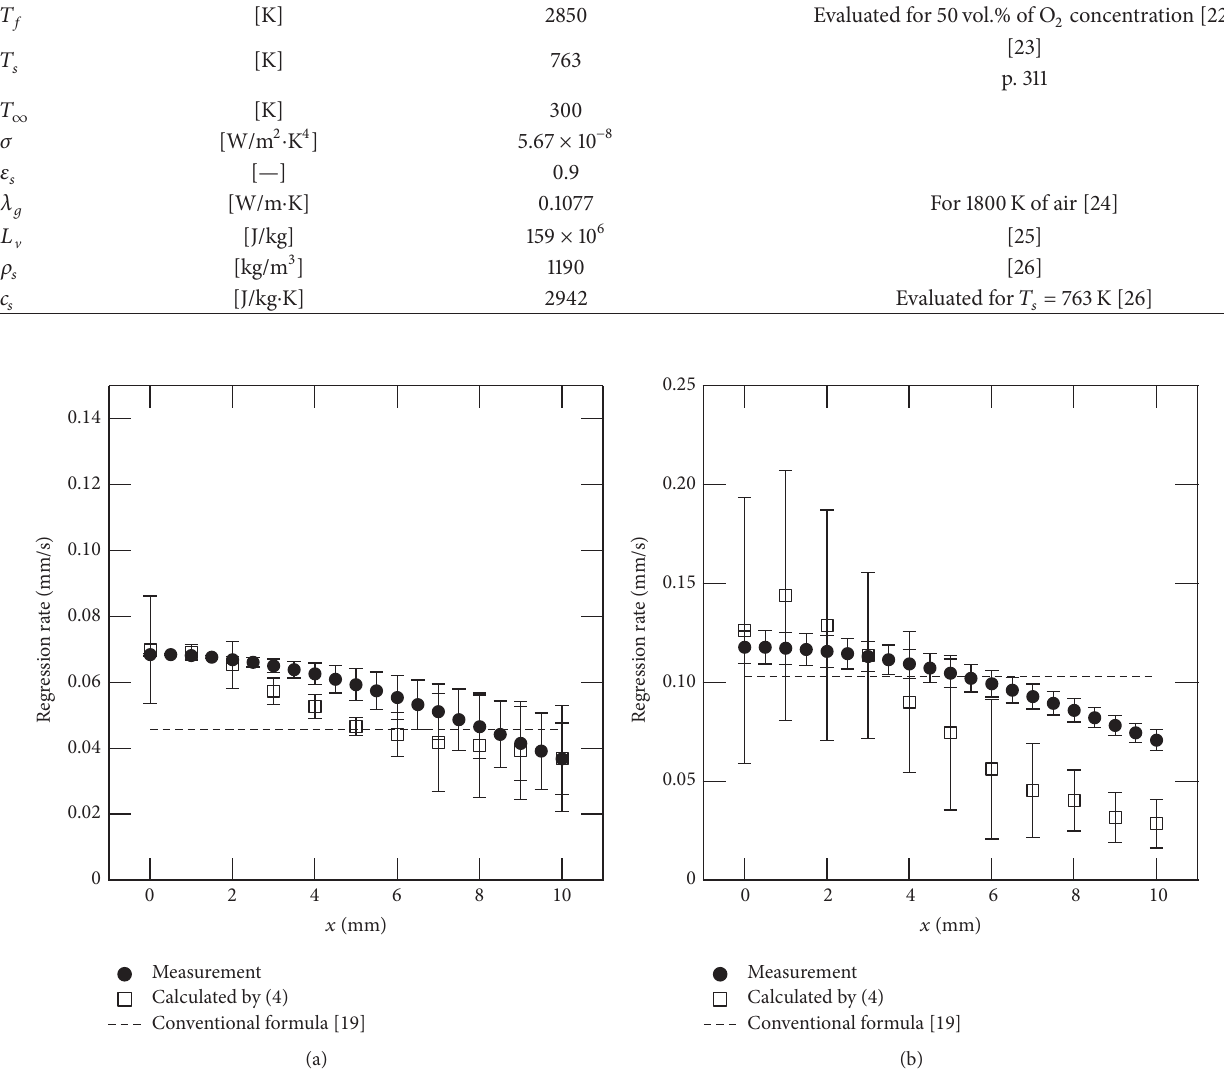
Table 1: Physical and chemical constants used for (4).